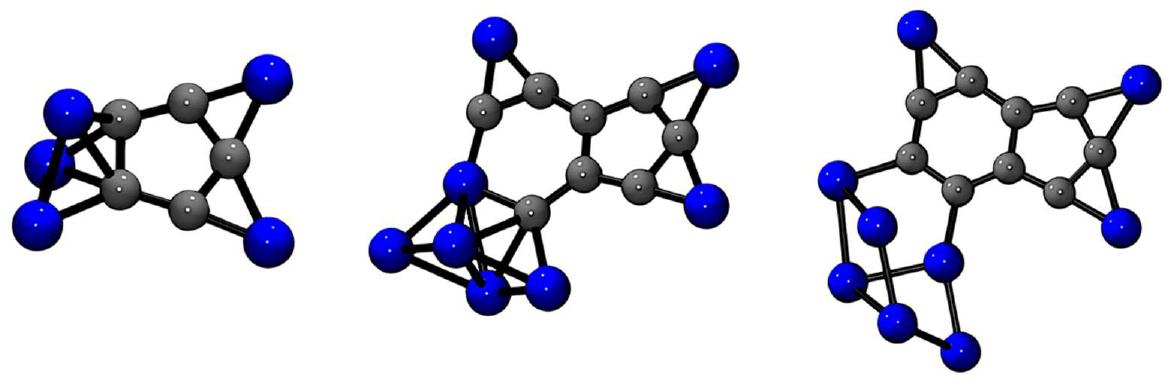
Figure 2. Structures of the Si n C n global minimum (n = 5, 8, 9) as reported in references [29–31] and confirmed in this work.